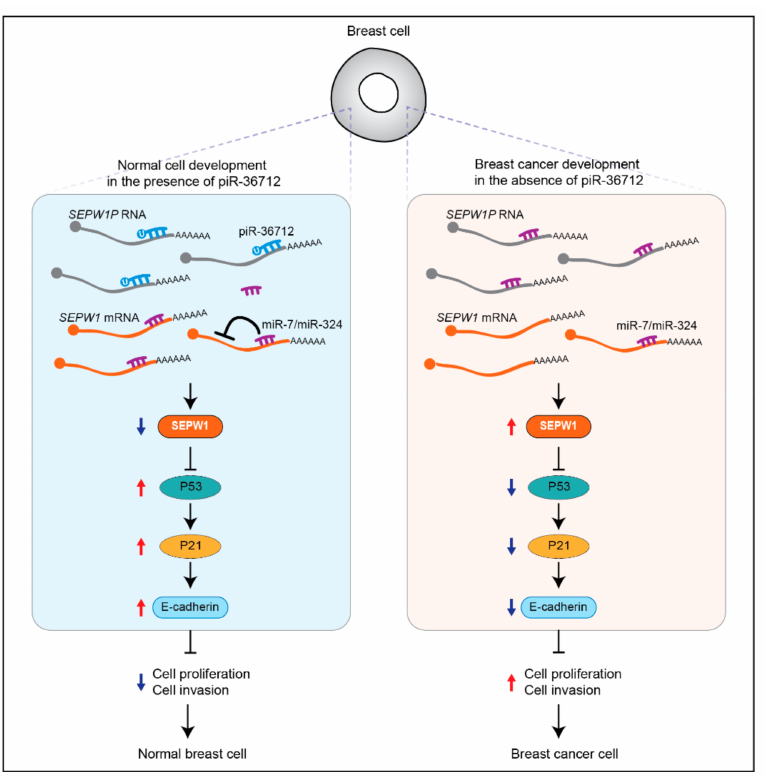
Figure 2. A tumor-suppressing piRNA in breast cancer. Left, piR-36712 binds and destabilizes SEPW1P RNA, a SEPW1 pseudogene, which inhibits SEPW1 expression by reducing SEPW1P levels. It increases P53, P21, and E-cadherin levels, and consequently, suppresses cancer development. Right, when piR-36712 is downregulated in breast cells, SEPW1 is highly expressed, and P53, P21, and E-cadherin levels are suppressed, which promotes breast cancer development